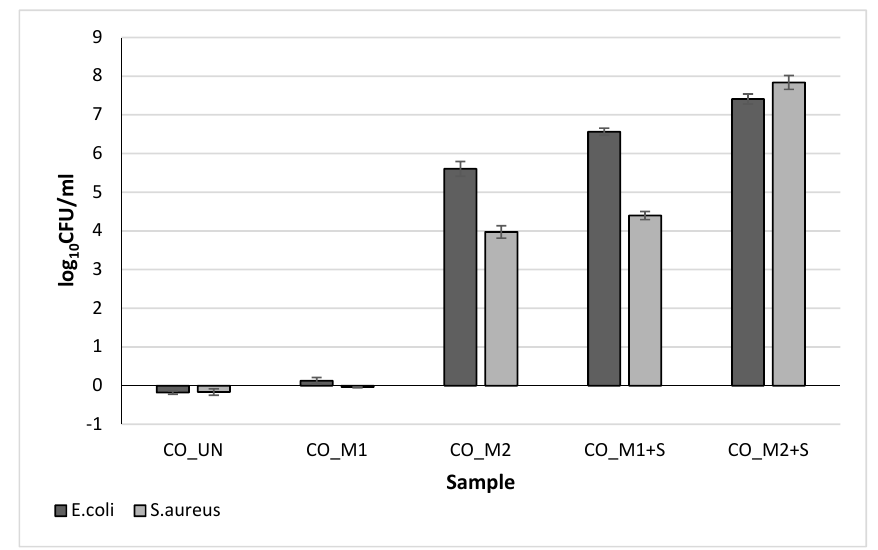
Figure 11. Antimicrobial activity of the studied samples based on the number of grown bacteria colonies right after the exposure to the studied samples and after 1 h exposure with the samples, determined for E. coli and S. aureus .